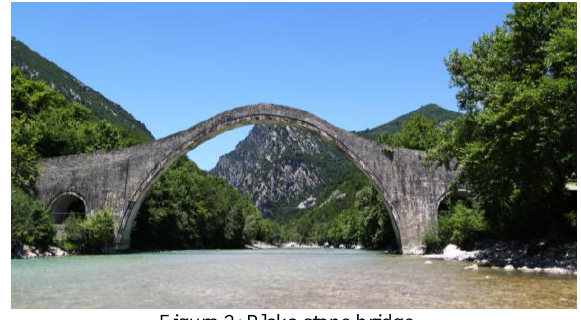
Figure 2: Plaka stone